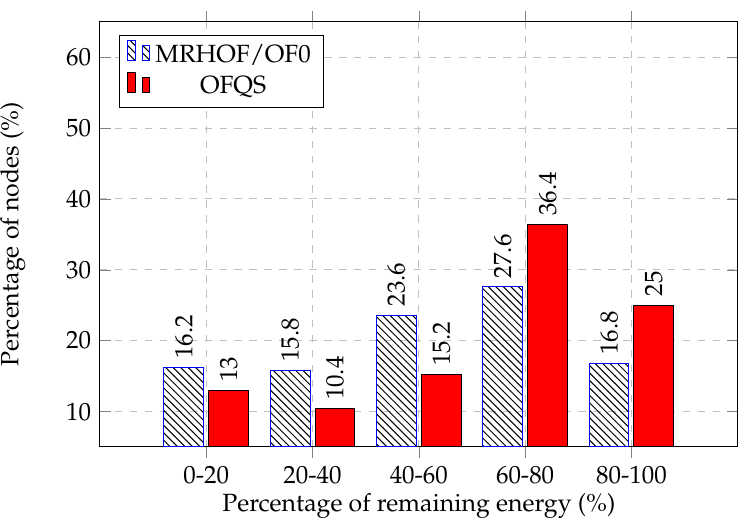
Figure 9. Remaining energy distribution among the nodes after 30